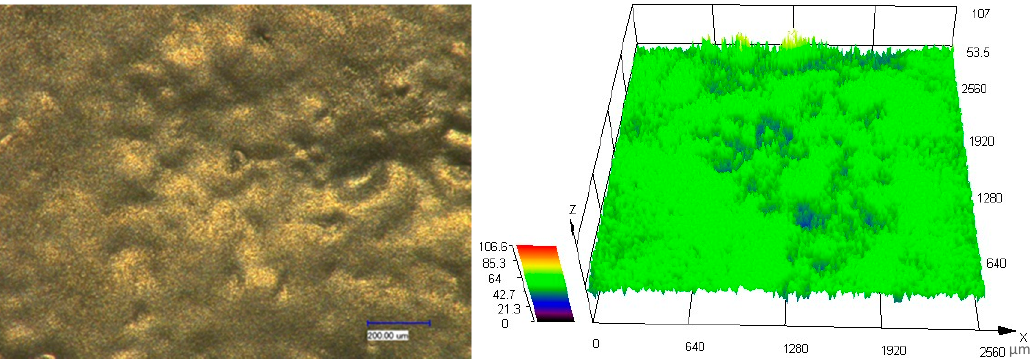
Figure 7. Surface microtopography and roughness of Co-38Mn-2La coating oxidized at 750 °C in air for 100 h.